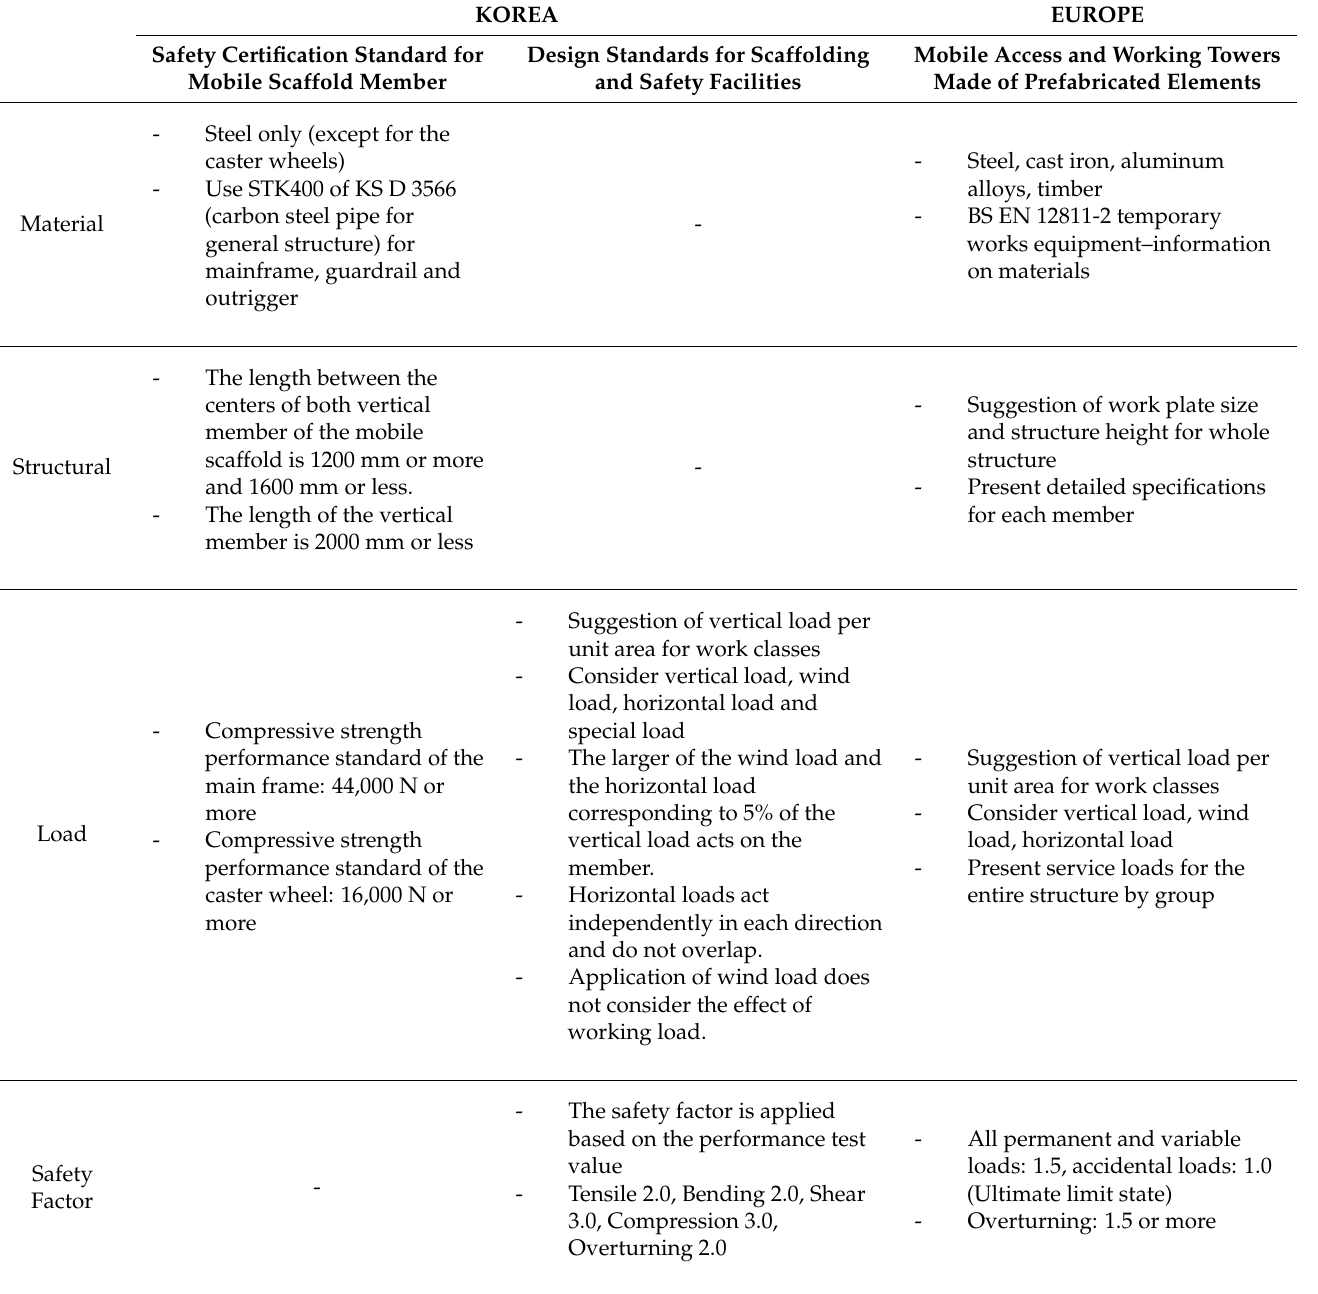
Table 11. Comparison of standards related to mobile scaffolding in Korea and